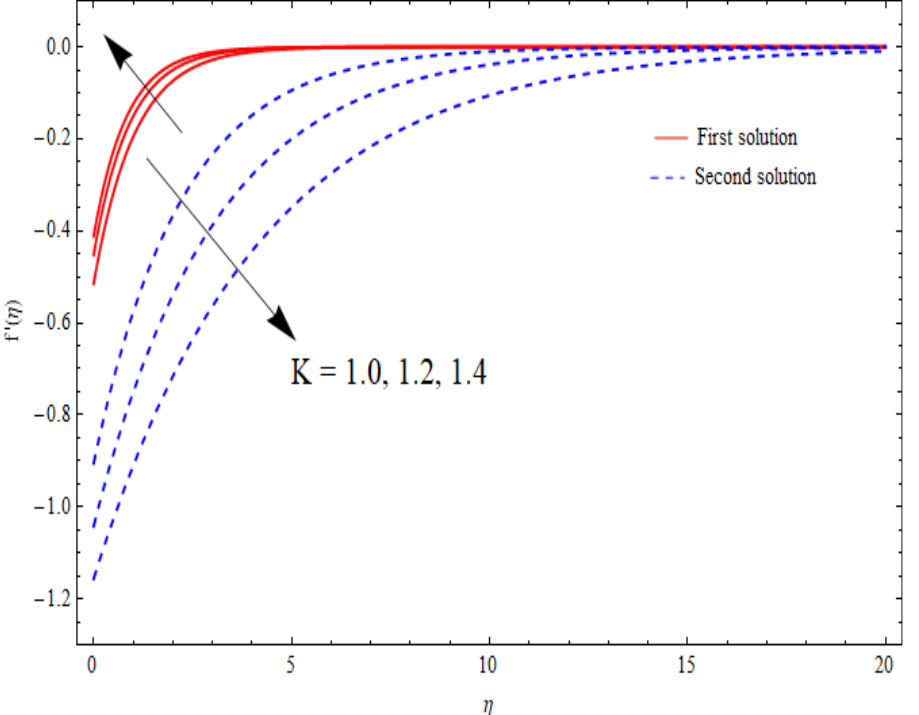
Figure 11. Velocity profiles f (cid:48) ( η ) for distinct k 1 when λ = − 1.5, s = 1 = γ , δ = − 1, ϕ 1 = 0.1 = ϕ 2